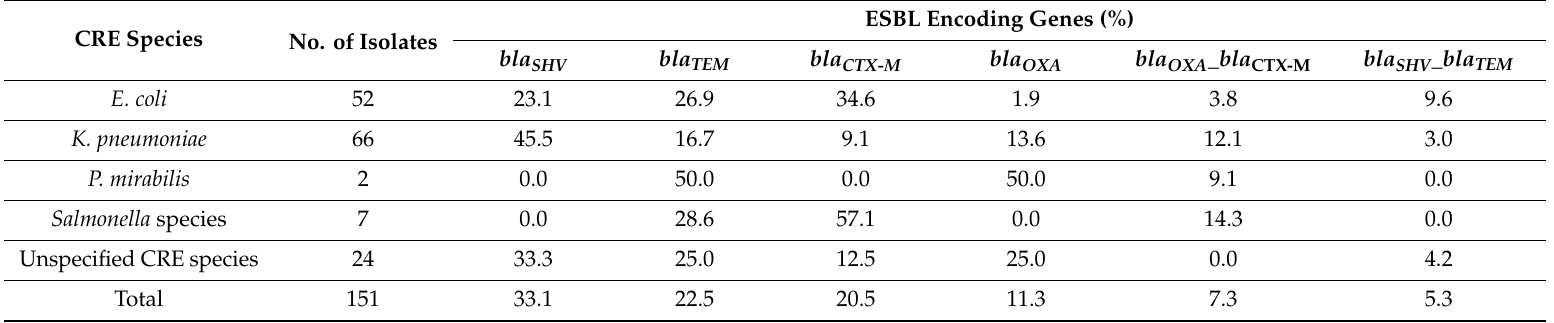
Table 2. Proportion of CRE species carrying ESBL